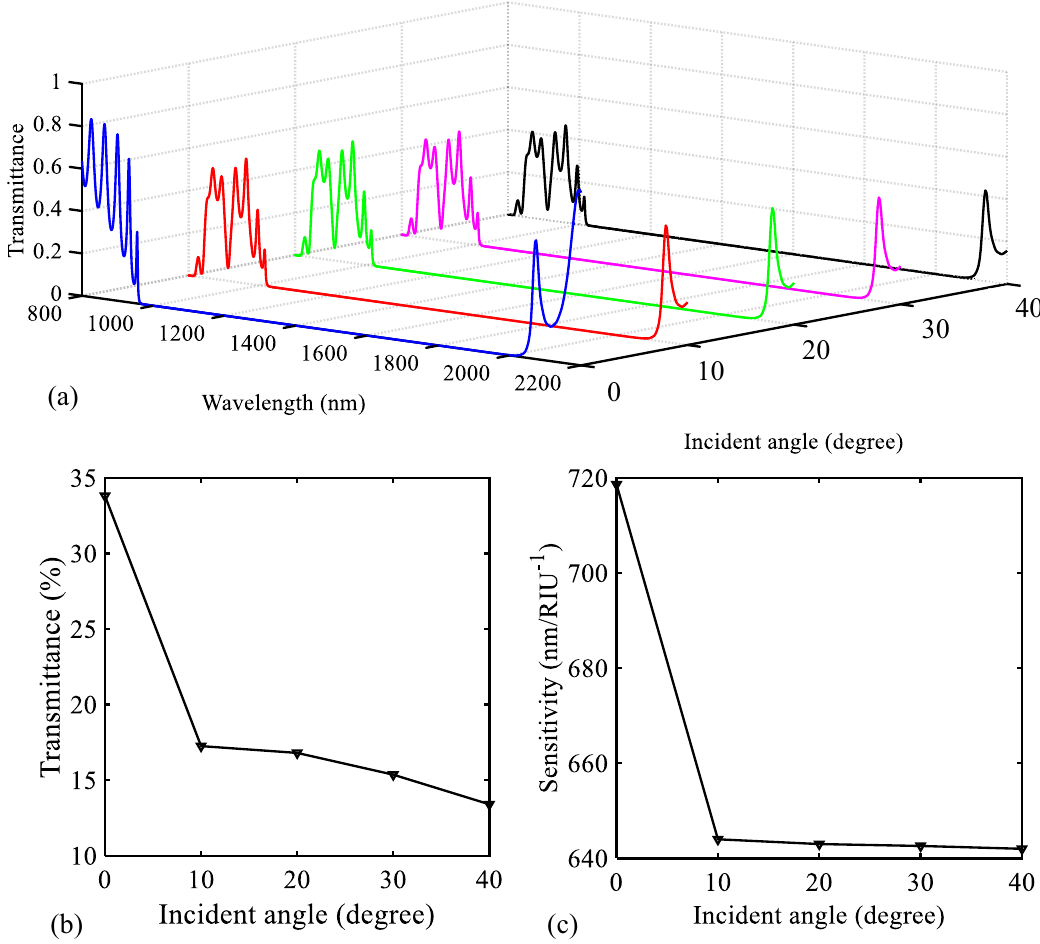
Figure 9. ( a ) Transmission spectra of the proposed biosensor I for different incident angles. ( b ) Relationship between the maximum transmission value of the low PBG edge and different values of the incident angle. ( c ) Relationship between the sensitivity value and different values of the incident